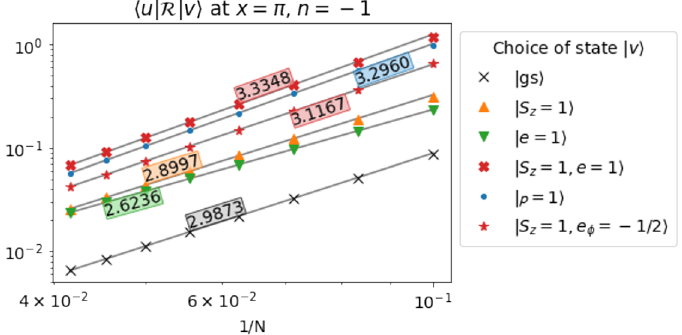
Figure 4 . Absolute value of matrix elements of R as de(cid:12)ned in (7.11), plotted using the same conventions as in (cid:12)gure